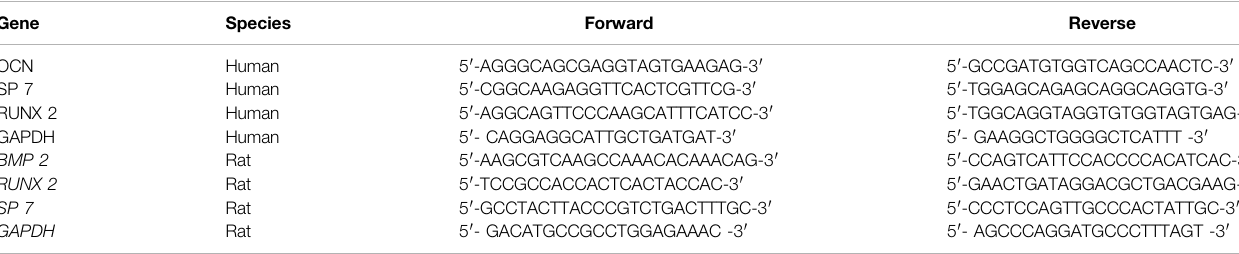
TABLE 1 | Primer sequences of genes related to ankylosing spondylitis. Gene